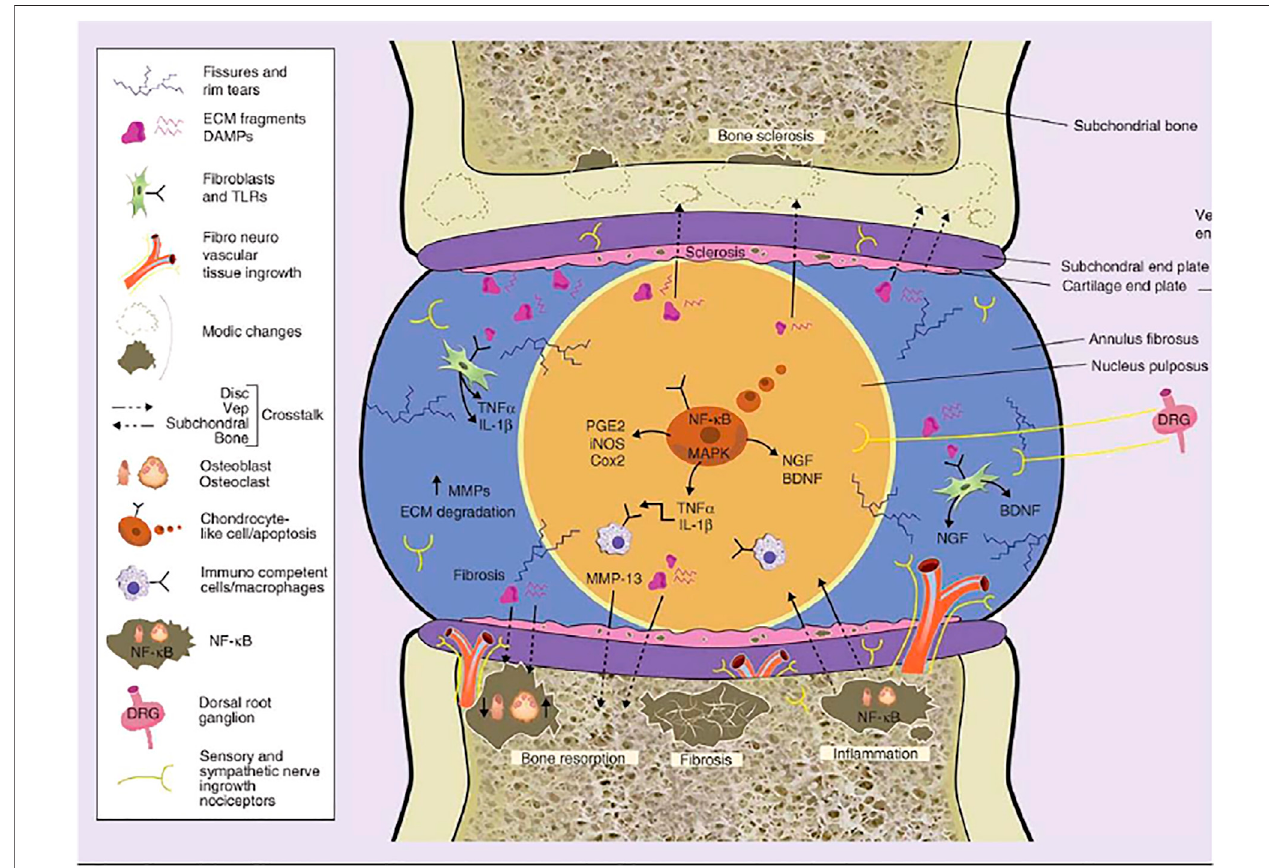
FIGURE 3 | The molecular mechanisms of low-grade in fl ammation in IVDJD and the crosstalk between intervertebral disc and subchondral bone. Reproduced from Eduardo et al. (Anitua and Padilla, 2018) with permission from Copyright 2018 Future Medicine.